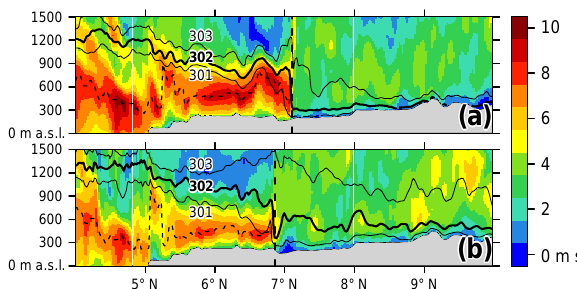
Figure 10. Same as Fig. 8a but for the (a) clean and (b) polluted